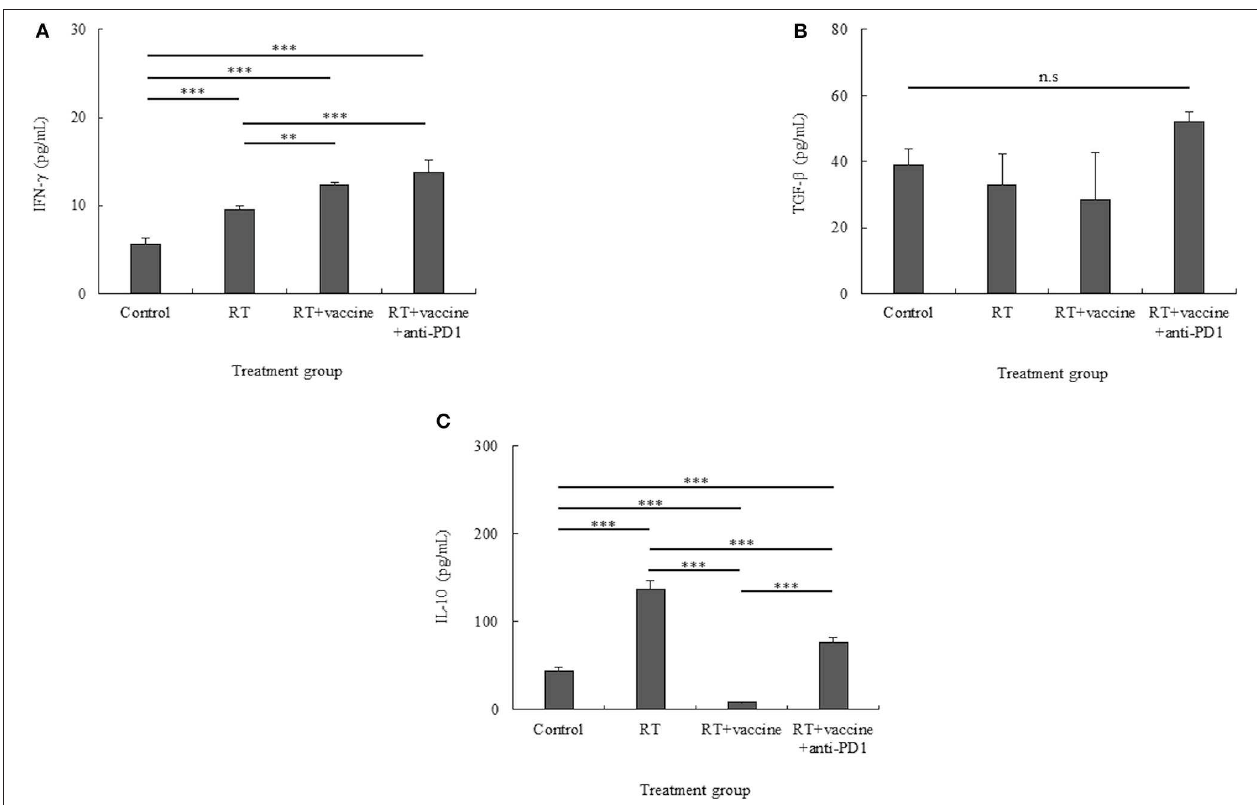
FIGURE 7 | Pro-inflammatory and anti-inflammatory cytokine production in the culture media of single tumor cells was confirmed using ELISA. Pro-inflammatory cytokines such as IFN- γ (A) and anti-inflammatory cytokines such as IL-10 and TGF- β (B,C) were identified. While IFN- γ showed an increase, TGF- β was stable in all the treatment groups, and IL-10 showed different levels according to the different treatments. Data are summarized by bar charts as the mean ± standard deviation (SD). All data are represented as the mean of two independent experiments. Control, no treatment group; RT, radiation; vaccine, branched multipeptide plus PADRE and poly-ICLC; ** p < 0.01; and *** p < 0.001; n.s., no significant